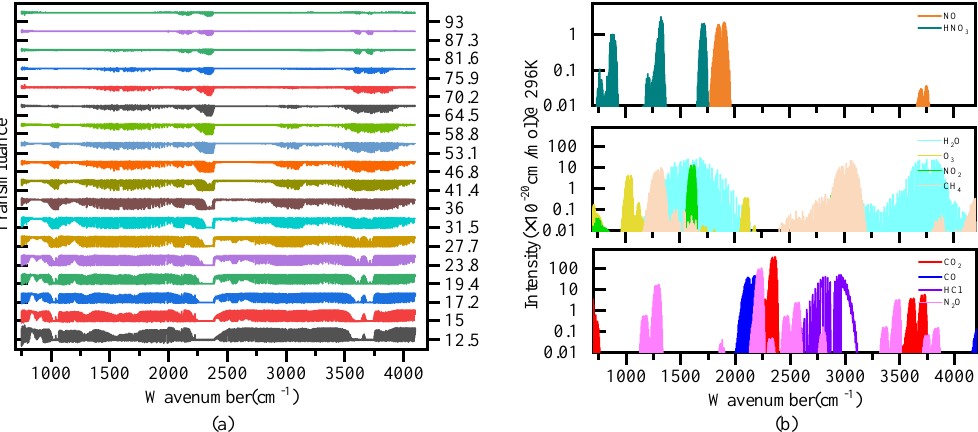
Figure 1. Atmospheric Infrared Ultraspectral Sounder (AIUS) measurement and the absorption line distribution in the 750–4100 cm − 1